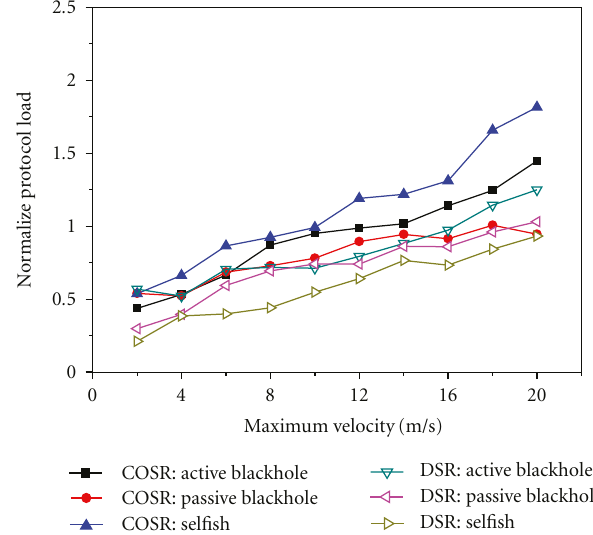
Figure 5: COSR against Liars.